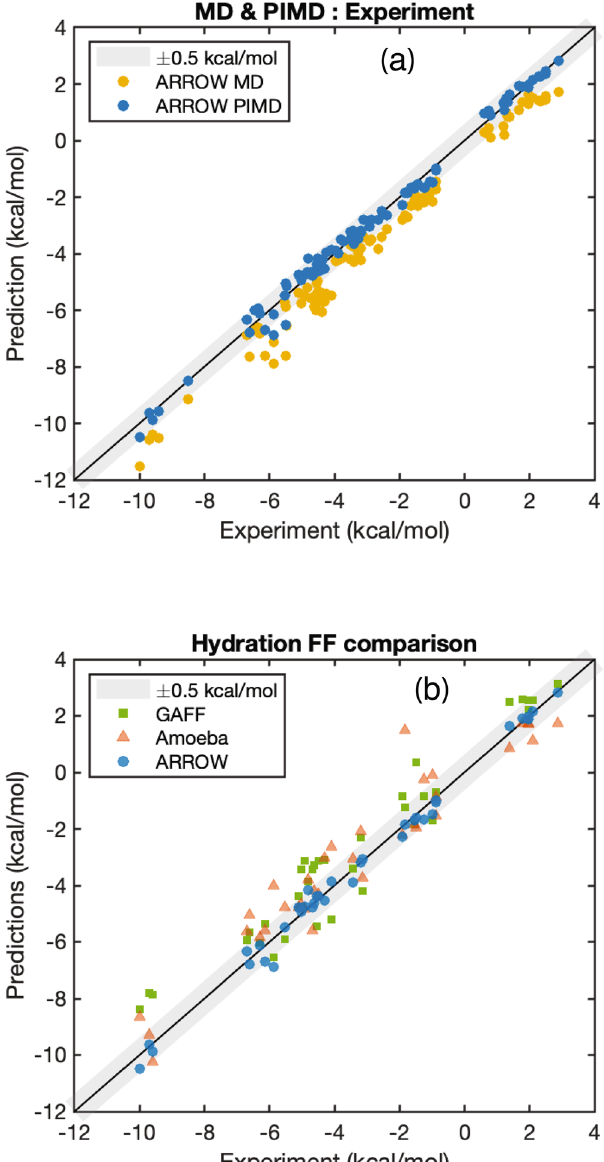
Fig. 4 NQE effect and comparison of hydration predictions. a A visual comparison of the hydration predictions vs. experimental values for PIMD8 vs. classical MD values. The inclusion of NQE systematically improves the predictions and decreases the overall error (MAE) from 0.78 to 0.2 kcal/ mol. b A comparison of the hydration free energies to state-of-the art wide coverage Force Fields. The molecules shown include the major functional groups that have been parametrized by all three models and are therefore a subset of those shown in Fig. 3a. The errors (MAE) for GAFF, AMOEBA, and ARROW FF are 0.88, 0.76, and 0.22 kcal/mol,